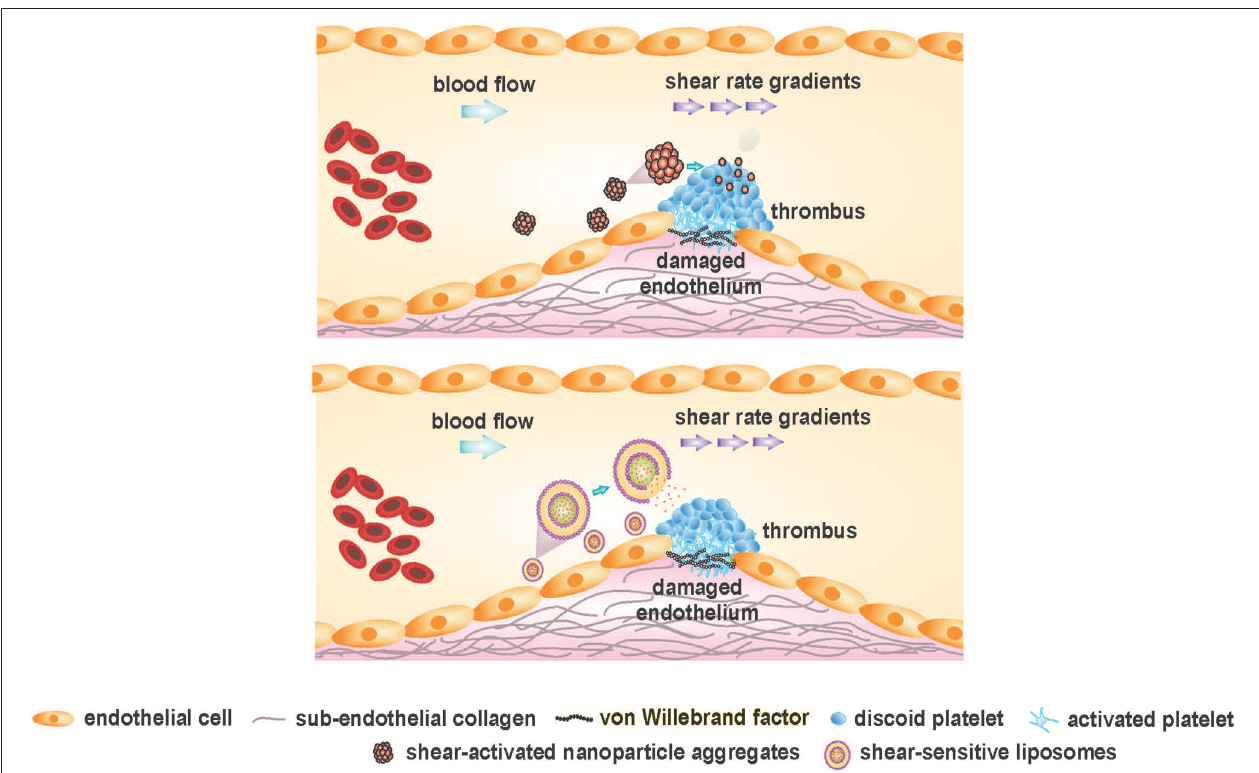
FIGURE 6 | Shear-sensitive drug delivery platforms targeting occlusive thrombus formation. Adapted and modified from Westein et al. (151) with permission from the